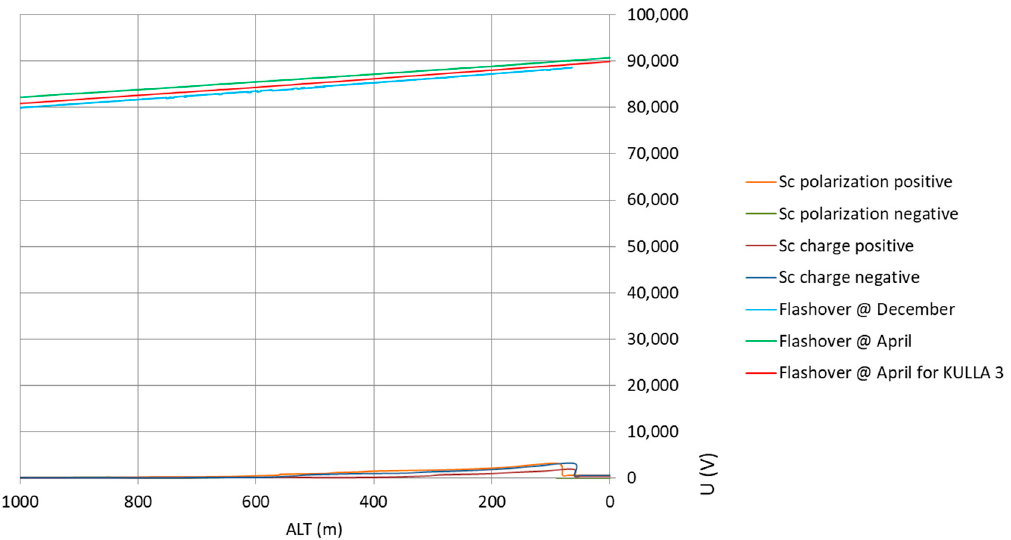
Figure 8. The flashover and induced voltage for the re-entry through the Stratocumulus clouds on the 500 m-long fully airborne antenna.